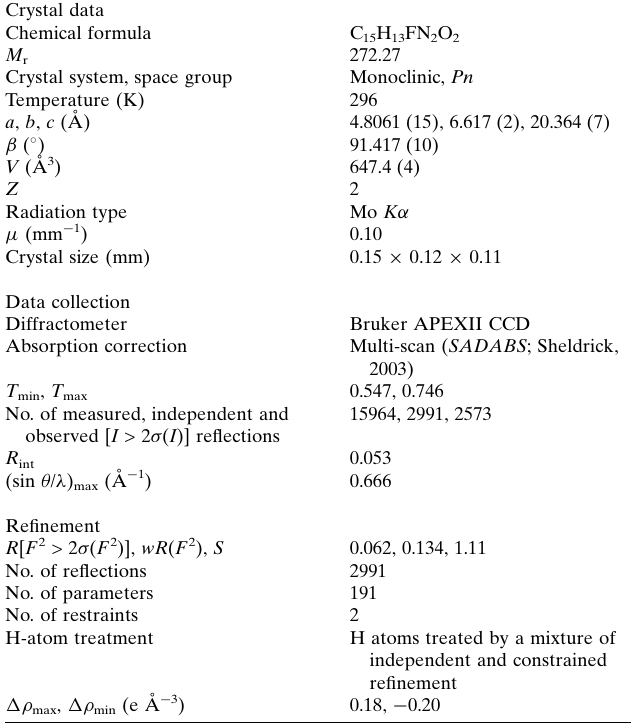
Figure 5 Two-dimensional fingerprint plots of the title compound, showing ( a ) all interactions, and delineated into ( b ) H (cid:3)(cid:3)(cid:3) H, ( c ) C (cid:3)(cid:3)(cid:3) H, ( d ) O (cid:3)(cid:3)(cid:3) H, ( e ) F (cid:3)(cid:3)(cid:3) H, ( f ) C (cid:3)(cid:3)(cid:3) C, ( g ) N (cid:3)(cid:3)(cid:3) H, ( h ) C (cid:3)(cid:3)(cid:3) O and (i) C (cid:3)(cid:3)(cid:3) N interactions [ d e and d i represent the distances from a point on the Hirshfeld surface to the nearest atoms outside (external) and inside (internal) the surface, respectively].